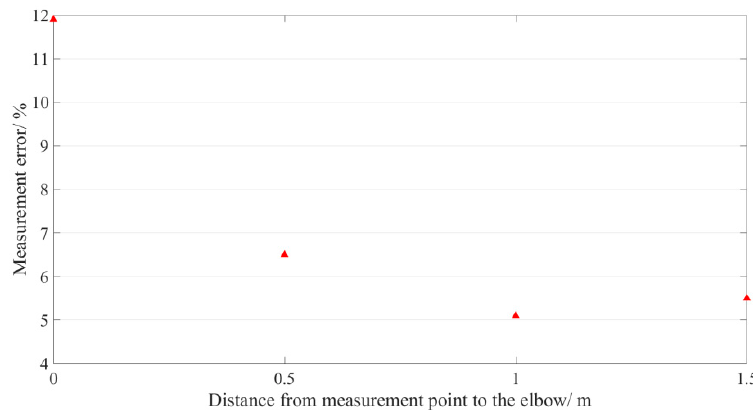
Figure 15. Fitting curve of the maximum errors of the four measurement points.